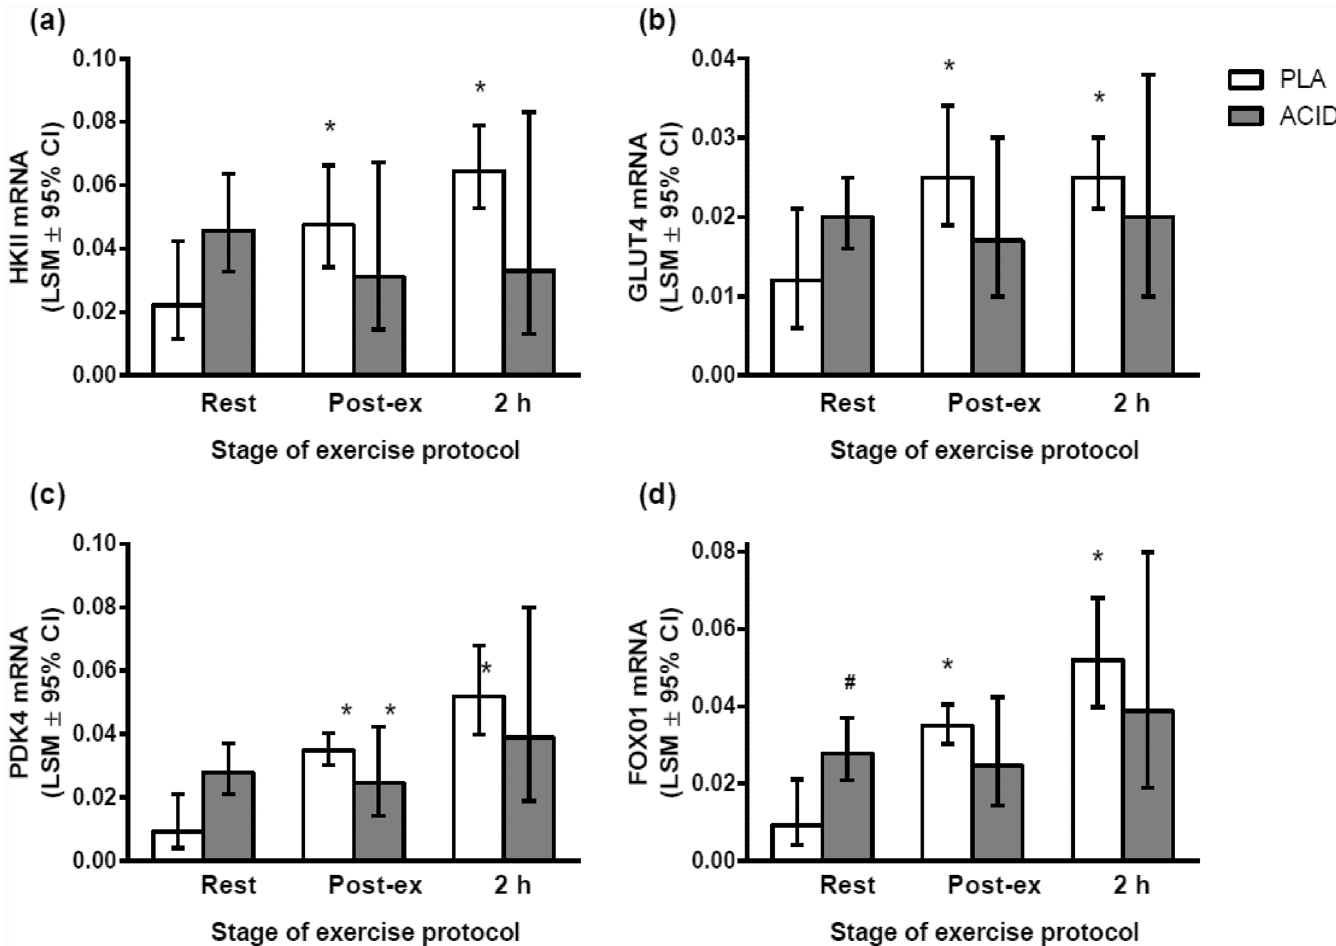
Fig 3. Gene expression responses to a high-intensity interval exercise bout (10 x 2 min @ 80% peak power output, 1 min @ 40% of peak power output) after the ingestion of ammonium chloride (ACID) or placebo (PLA). The total ingestion of each supplement was 0.15 g (cid:1) kg -1 on the day of the exercise protocol, equaling that consumed on the day prior to the trial. (a) HKII, (b) GLUT4, (C) PDK4; (d) FOXO1. # significantly different to placebo at same time point (P < 0.05); * significantly different to same ingested substance at rest (P < 0.05). Values are least square means ± 95% confidence limits.